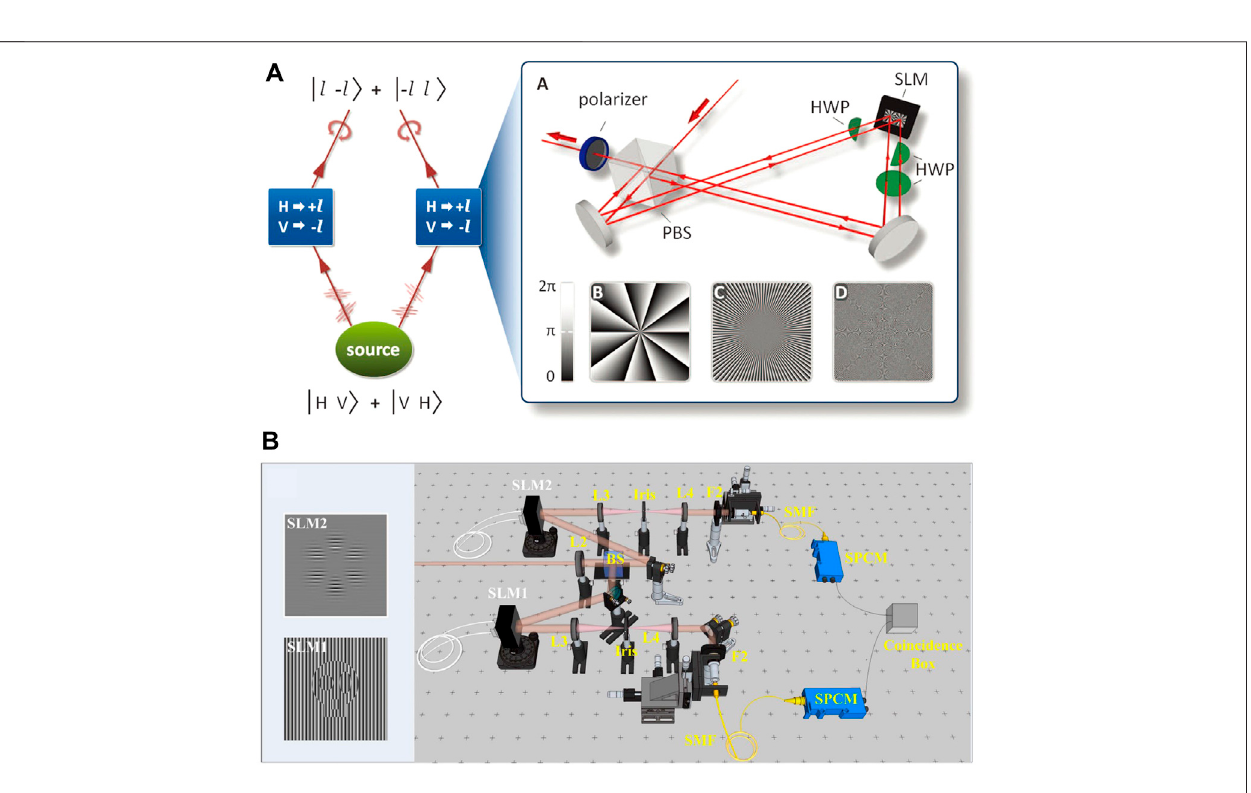
Frontiers in Physics |